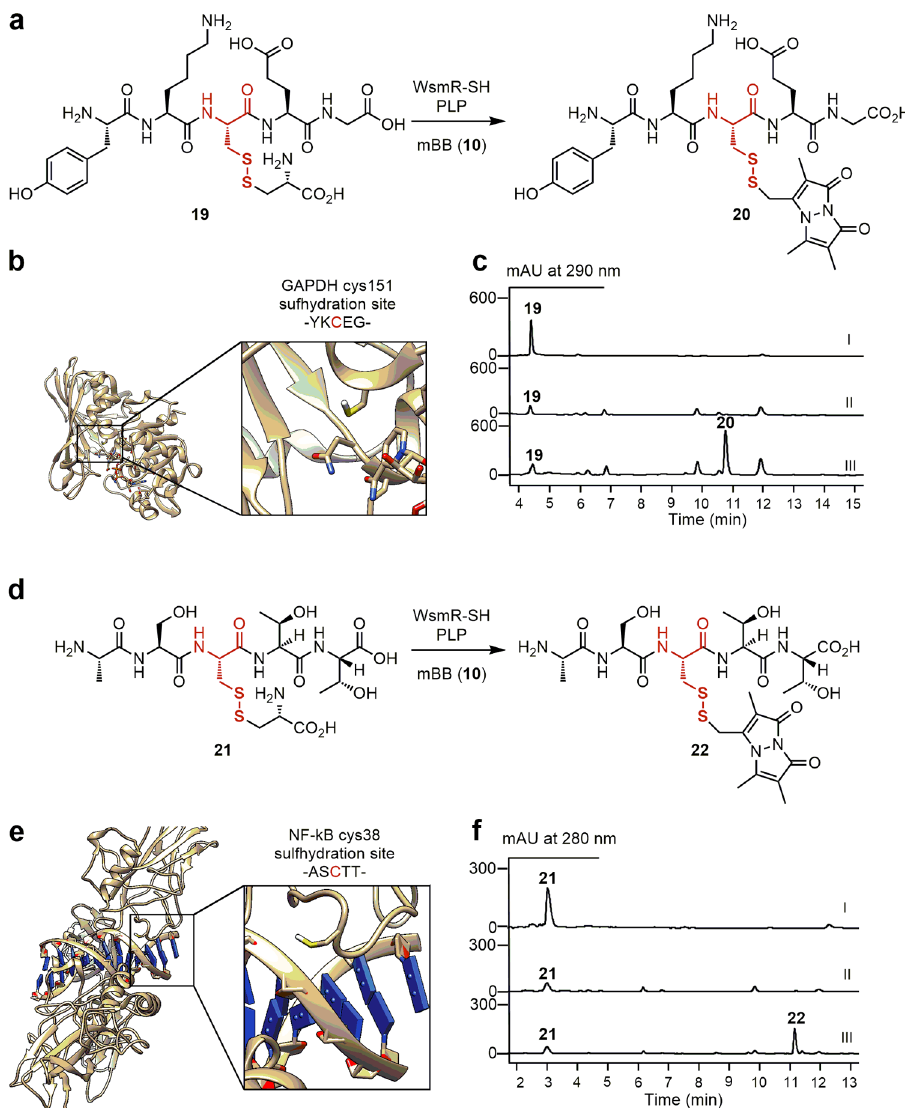
Fig. 5 Leveraging the SH domains as biocatalysts to install an -SSH group into varying peptide scaffolds. WsmR-SH-catalyzed synthesis of a 20 and d 22 from the L -thiocysteine-pentapeptide adducts 19 and 21 as substrate mimics for GAPDH and NF-kB, respectively. The crystal structures of b GAPDH (PDB: 1ZNQ) and e NF-kB (PDB: 1LE9) highlighting the Cys151 and Cys38 residues that undergo sulfhydration, respectively. HPLC analysis of in vitro assays of c (I) substrate 19 , (II) 19 + WsmR-SH (boiled) + 10 , and (III) 19 + WmR-SH + 10 and f , (I) substrate 21 , (II) 21 + WsmR-SH (boiled) + 10 , and (III) 21 + WmR-SH + 10 . Substrate and enzyme concentrations used: 19 or 21 , 2 mM; and WsmR-SH, 30 μ M. Incubation time: 30 min. The concentration of 10 used to trap the resultant hydropersul fi de product in situ as 20 or 22 , respectively: 2